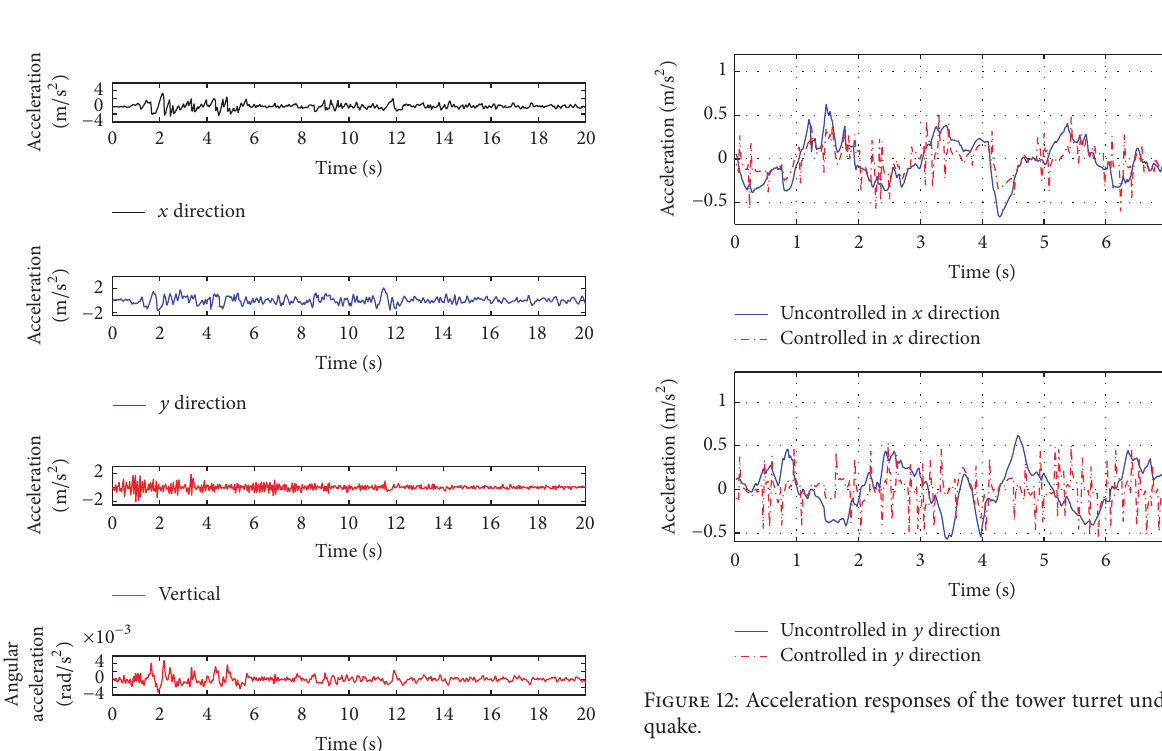
respectively, driven by the synchronous motor. The multidi- mensional seismic responses and the damping effect of the TV Tower with the multiple cardan gyroscope dampers are calculated.